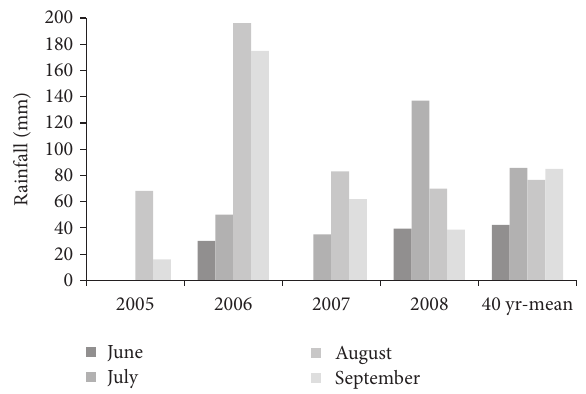
Table 3: Grass density (plants m − 2 ; mean ± SE) under different biosolids rates and two methods of biosolids application at a seeded abandoned field in Chihuahua,